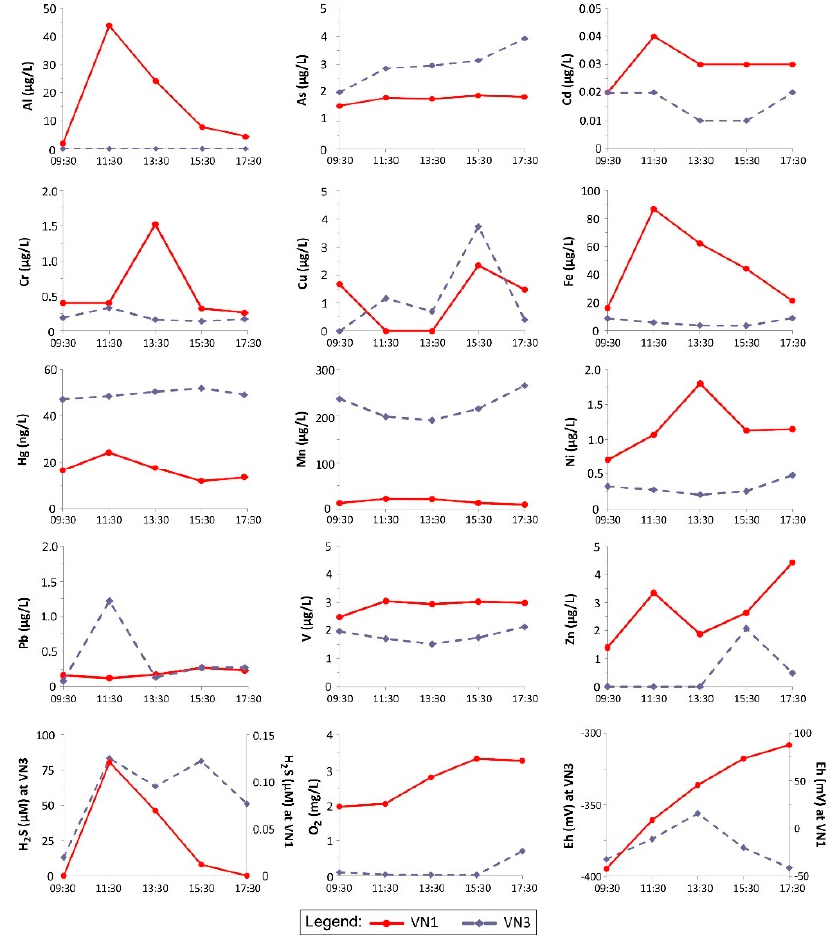
Figure 5. Concentrations of metal(loid)s, hydrogen sulphide (H 2 S, [12]), dissolved oxygen and Eh values vs. time in the benthic chamber at VN1 and VN3.